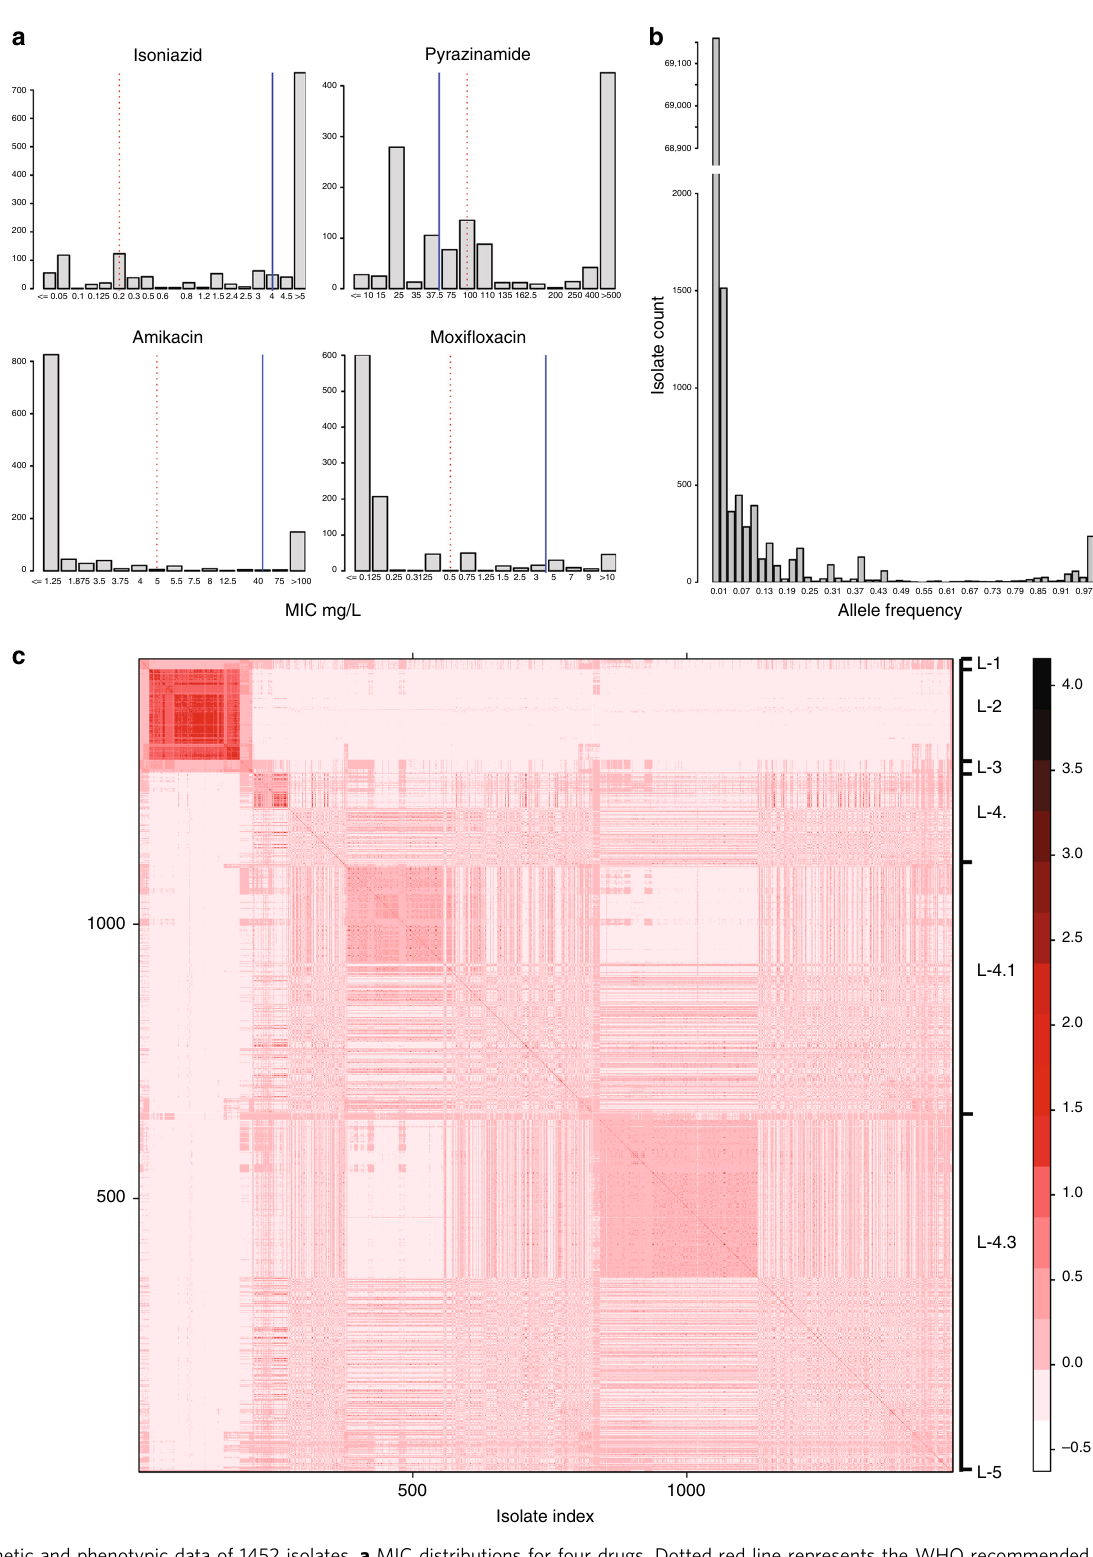
Fig. 1 Genetic and phenotypic data of 1452 isolates. a MIC distributions for four drugs. Dotted red line represents the WHO recommended critical concentration on 7H10 media; blue line represents the lower limit of achievable serum concentration from pharmacodynamic studies (Supplementary Table 2). b Allele frequency distribution relative to H37Rv. The isolate count axis interrupted and scaled to accommodate the data range. c Heatmap displaying genome-level similarity of the isolates. Similarity assessed as isolate – isolate genetic co-variance. Isolates indexed in lineage order L1, L2, L3, L4 (4., 4.1, 4.3), and L5 as shown. Co-variance ruler displayed on the far right with darker red indicating higher similarity/co-variance. Phylogenetic tree of the same isolates is given in Supplementary Fig. 4. Figure 1a – c can be regenerated using code in Supplementary Data 8 that will refer to data items provided in the Source Data fi le (compressed source data